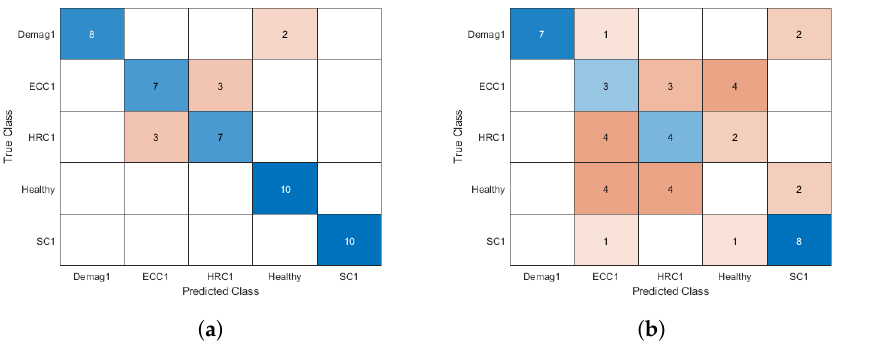
Figure 20. Confusion matrix of LDA classifier for fault diagnosis for: ( a ) FOC drives and ( b ) DTC